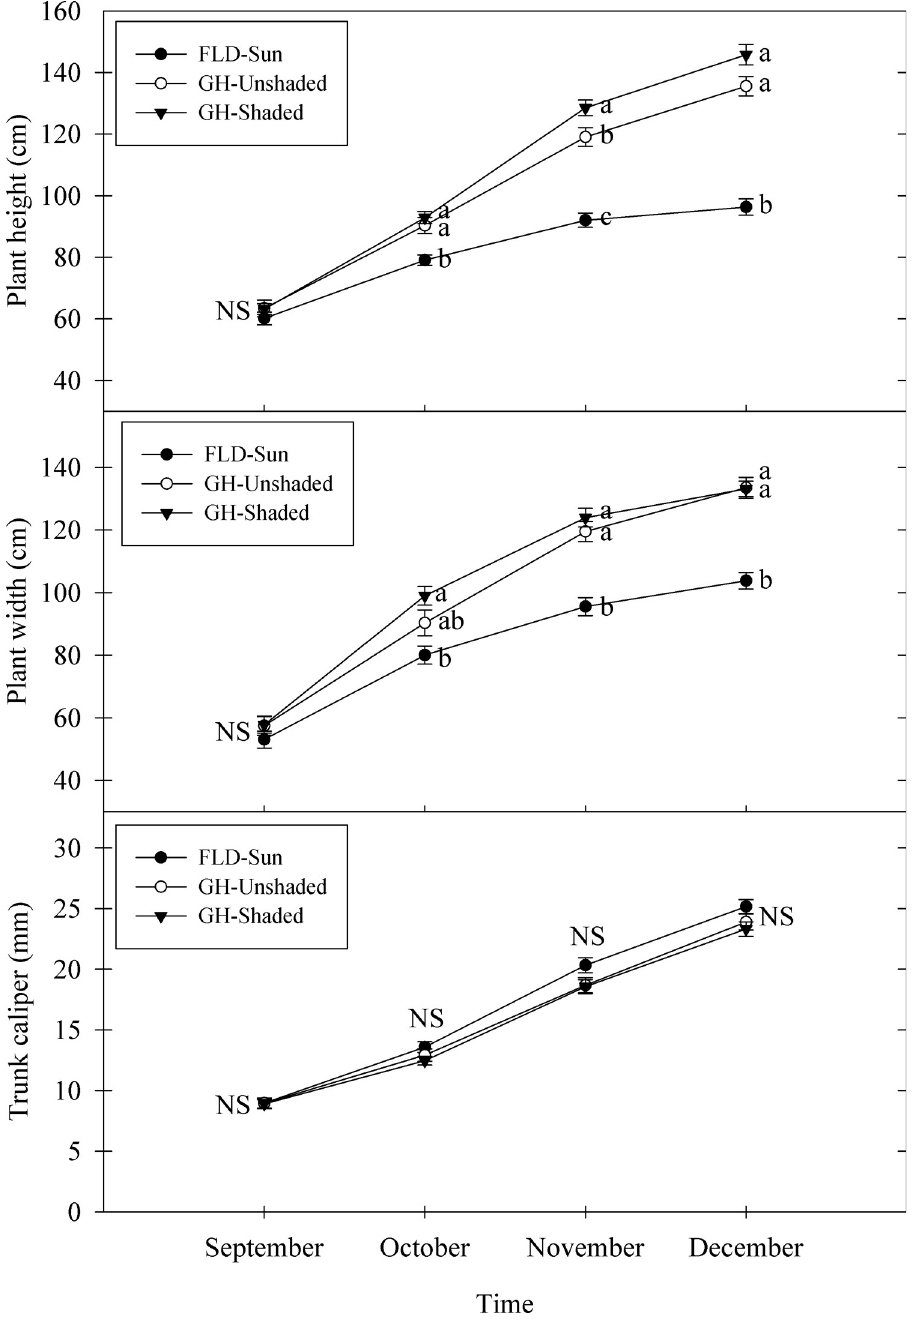
Fig 1. Plant height, width, and trunk caliper of kratom cultivated under varying radiance. FLD = field; GH = greenhouse. Data were pooled from twenty replicates per treatment (n = 60) each month. Means sharing the same letter are not statistically different by Tukey’s honest significant difference test at P < 0 . 05 . Error bars indicate the standard error. NS = not